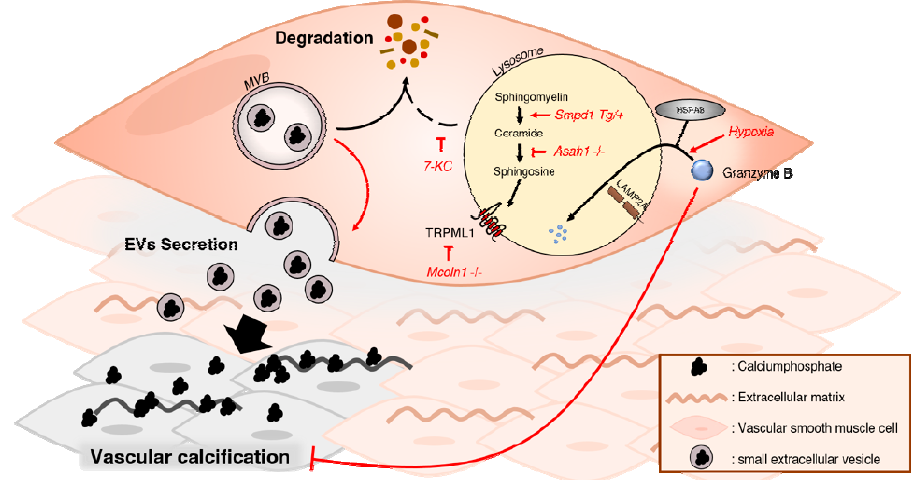
Figure 4. Modulating lysosomal function in vascular calcification. In a pro-calcific environment, calciumphosphate-loaded multivesicular bodies (MVBs), a type of late endosome, can either be degraded or secrete their contents to the extracellular matrix. In physiological conditions, there is a balance between degradation and secretion. Impairment of lysosomal function leads to decreased degradation of MVBs and enhanced secretion of pro-calcific extracellular vesicles (EVs). Transient receptor potential mucolipin 1 (TRPML1) is important for proper lysosome functioning, mediating the fusion of lysosomes with autophagosomes and endosomes. Knockout of the TRPML1 channel through the deletion of the mucolipin 1 gene, Mcoln1 , impairs lysosome function, thereby enhancing the release of pro-calcific EVs and aggravating vascular calcification (VCN). Sphingosine is necessary for TRPML1 activity. Impairing the biosynthesis of sphingosine from ceramide, through the inhibition of the enzyme acid ceramidase, consequently impairs TRPML1 function, leading to enhanced sEV secretion and VCN. The balance between ceramide and sphingosine levels inside the lysosome dictates lysosomal function. Enhanced levels of ceramide through overexpression of the Smpd1 gene, which encodes for acid sphingomyelinase, impairs lysosome function. Overexpression of Smpd1 leads to enhanced secretion of EVs and VCN. Additionally, impairing lysosomal function with 7-ketocholesterol aggravates VCN. Finally, in a hypoxic environment, granzyme B is degraded via Heat shock protein family A (Hsp70) member 8 (HSPA8)-dependent chaperone-mediated autophagy. However, granzyme B has been shown to be protective against VCN. Therefore, chaperone-mediated autophagy worsens hypoxia-induced calcification. sEV = small Extracellular vesicle, MVB = Multivesicular bodies, HSPA8 = Heat shock protein family A (Hsp70) member